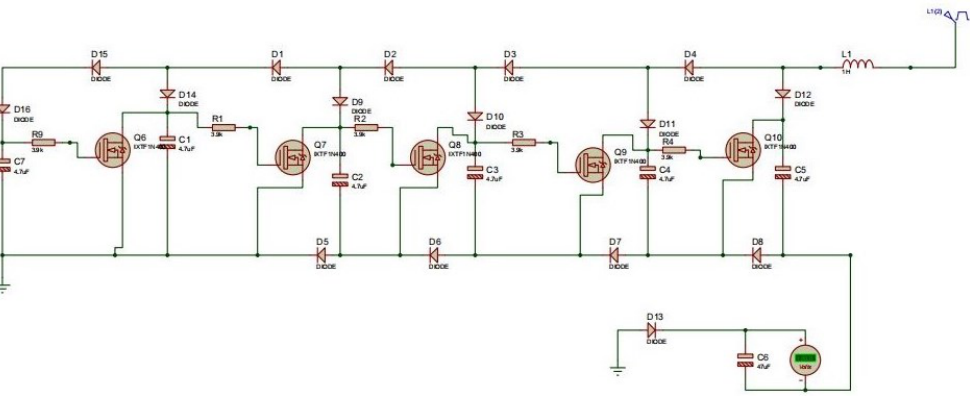
Figure 6. Multistage modified Marx generator without an optocoupler.